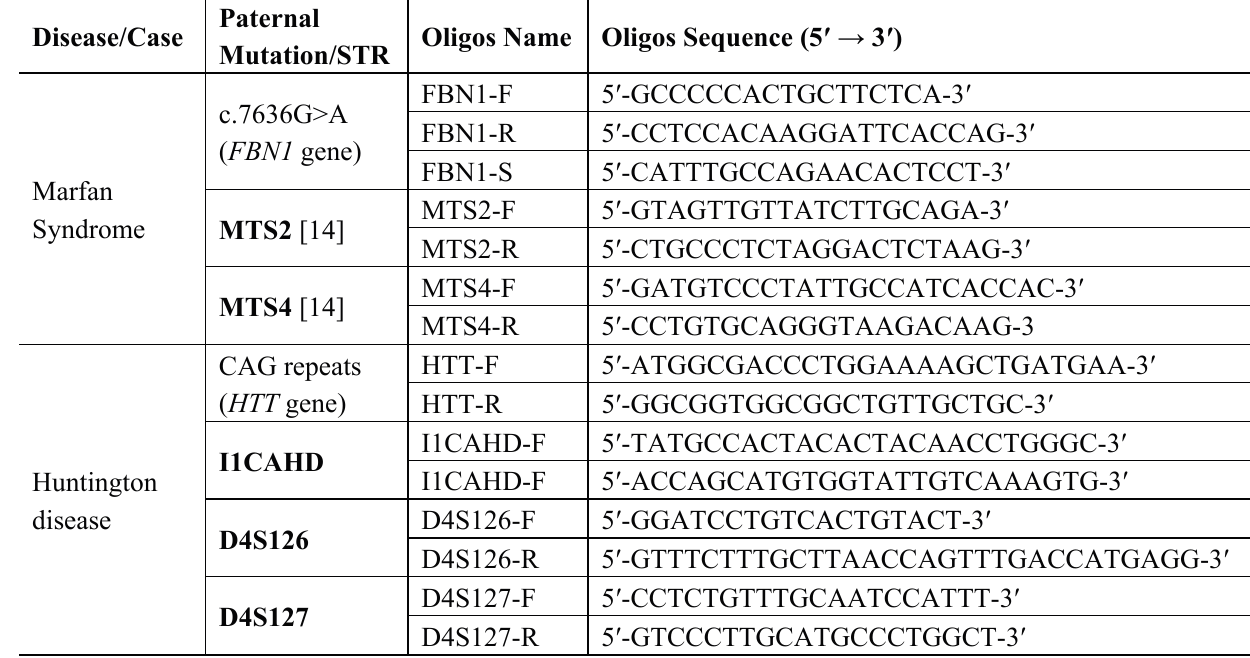
Table 1. Table with oligos sequences used in the